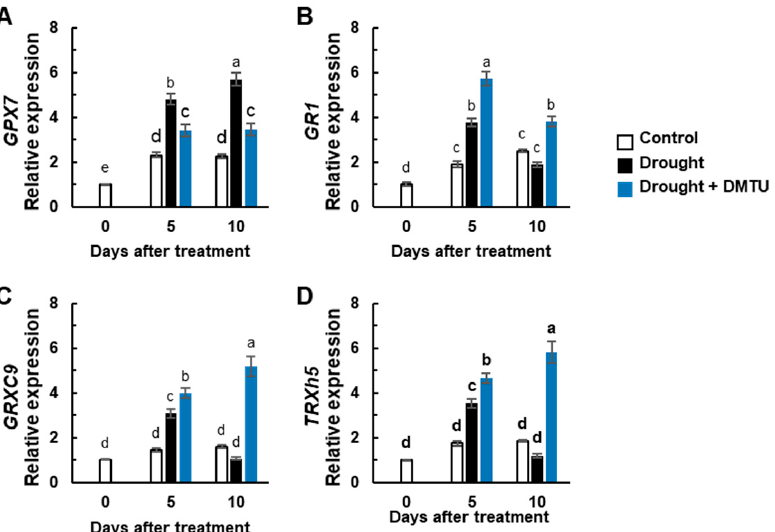
Figure 5. The changes of expression of redox regulating genes in the leaves of Brassica napus under control, drought, or drought with dimethylthiourea (Drought + DMTU) treatments for 10 days. The expression of ( A ) glutathione peroxidase 7 ( GPX7 ), ( B ) glutathione reductase 1 ( GR1 ), ( C ) CC-type glutaredoxin 9 ( GRXC9 ), and ( D ) thioredoxin-h5 ( TRXh5 ). The transcriptional levels in control plants at day 0 were set to 1. Results are represented as mean ± SE for n = 3. Means with different letters are significantly different at p < 0.05, according to Duncan’s multiple range test.